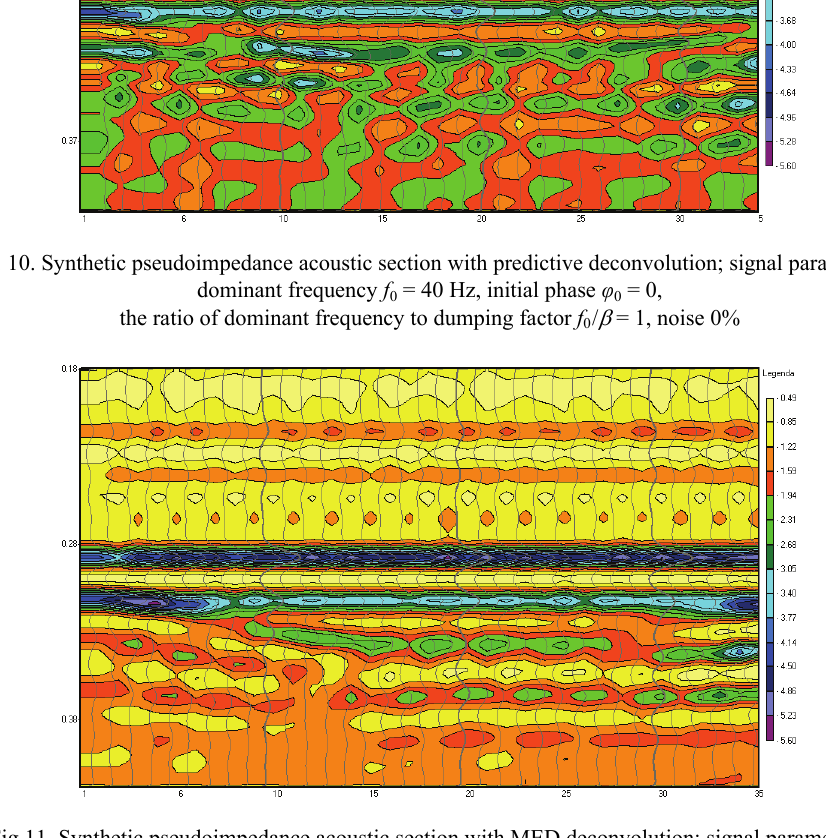
Fig.11. Synthetic pseudoimpedance acoustic section with MED deconvolution; signal parameters: dominant frequency f 0 = 40 Hz, initial phase φ 0 = 0, the ratio of dominant frequency to dumping factor f 0 / β =1, noise 0%